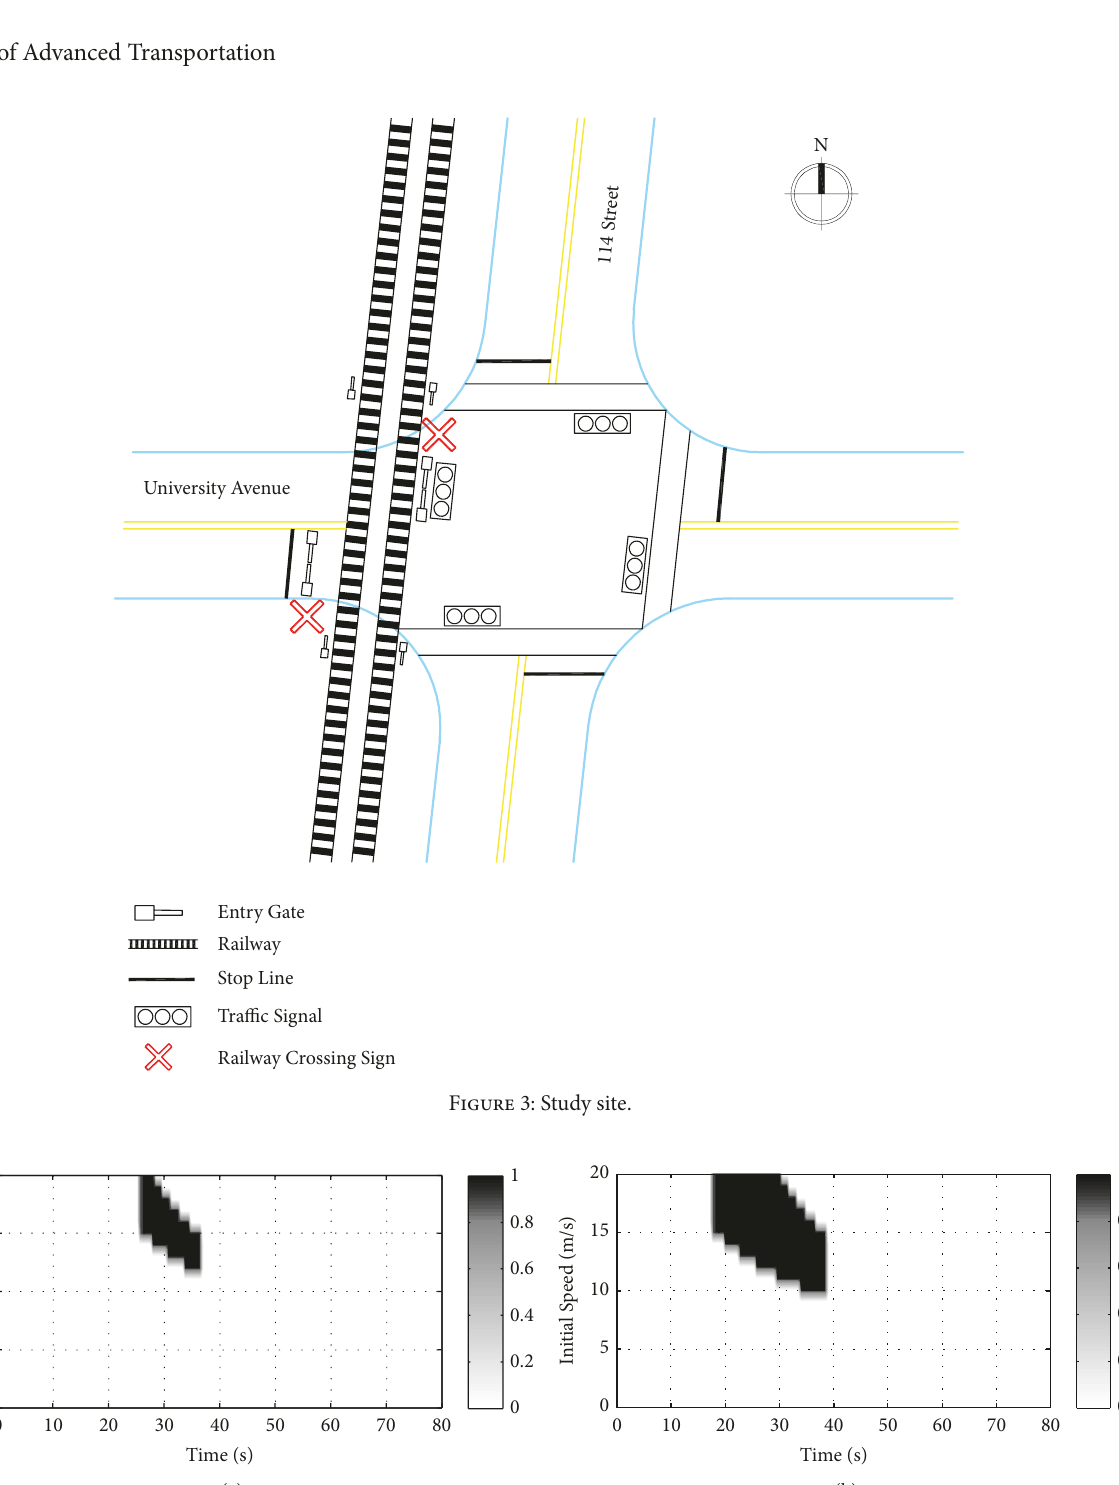
simulation. The three cases show how the crossing risk varies for road users in different